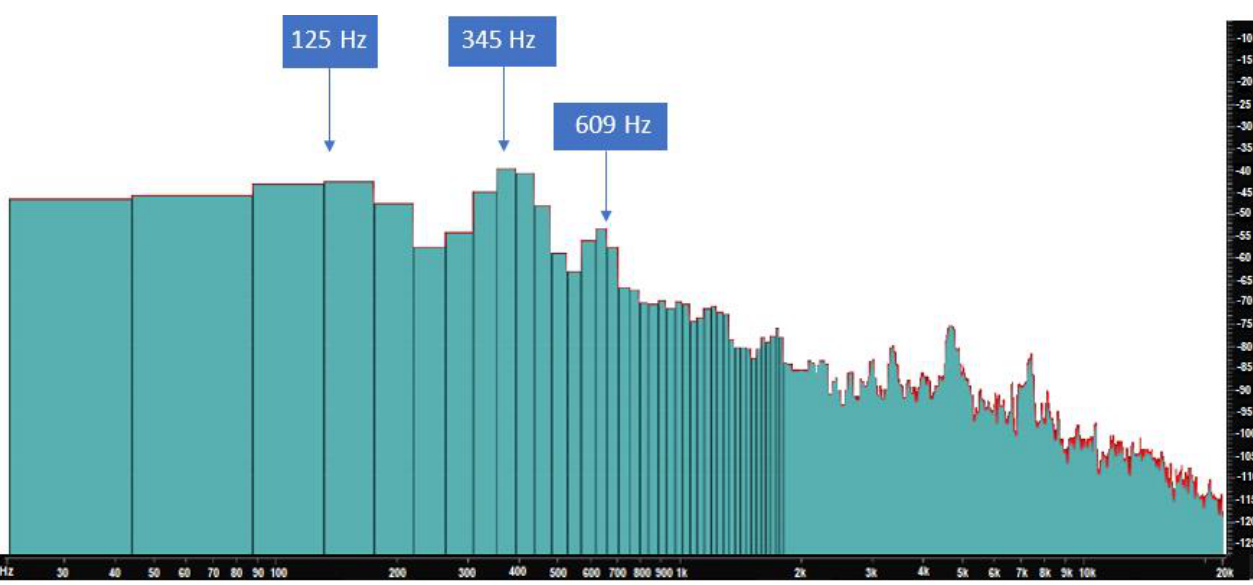
Figure 4. Frequency spectrum measured 2 m in front of the transformer, at the point labeled “MP #9” in Figure 3.